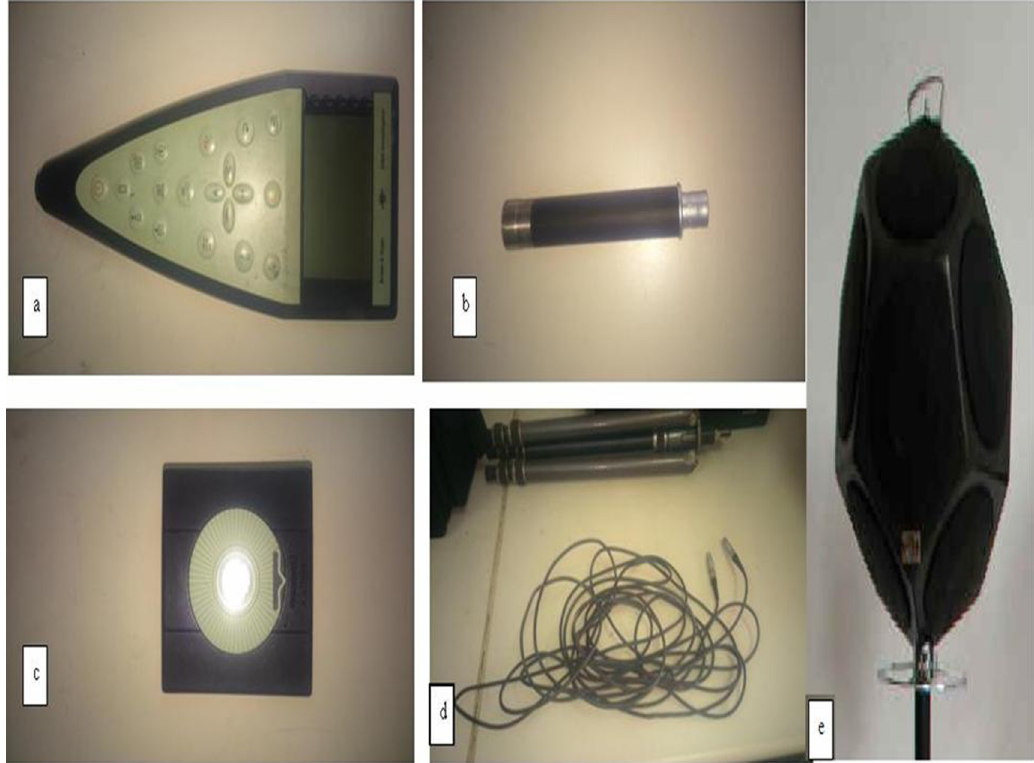
Fig. 1. (a) Used sound level meter, (b) microphone with pre-ampli fi er, (c) calibrator for noise measurement, (d) stand, cable, and (e) used loud speaker.